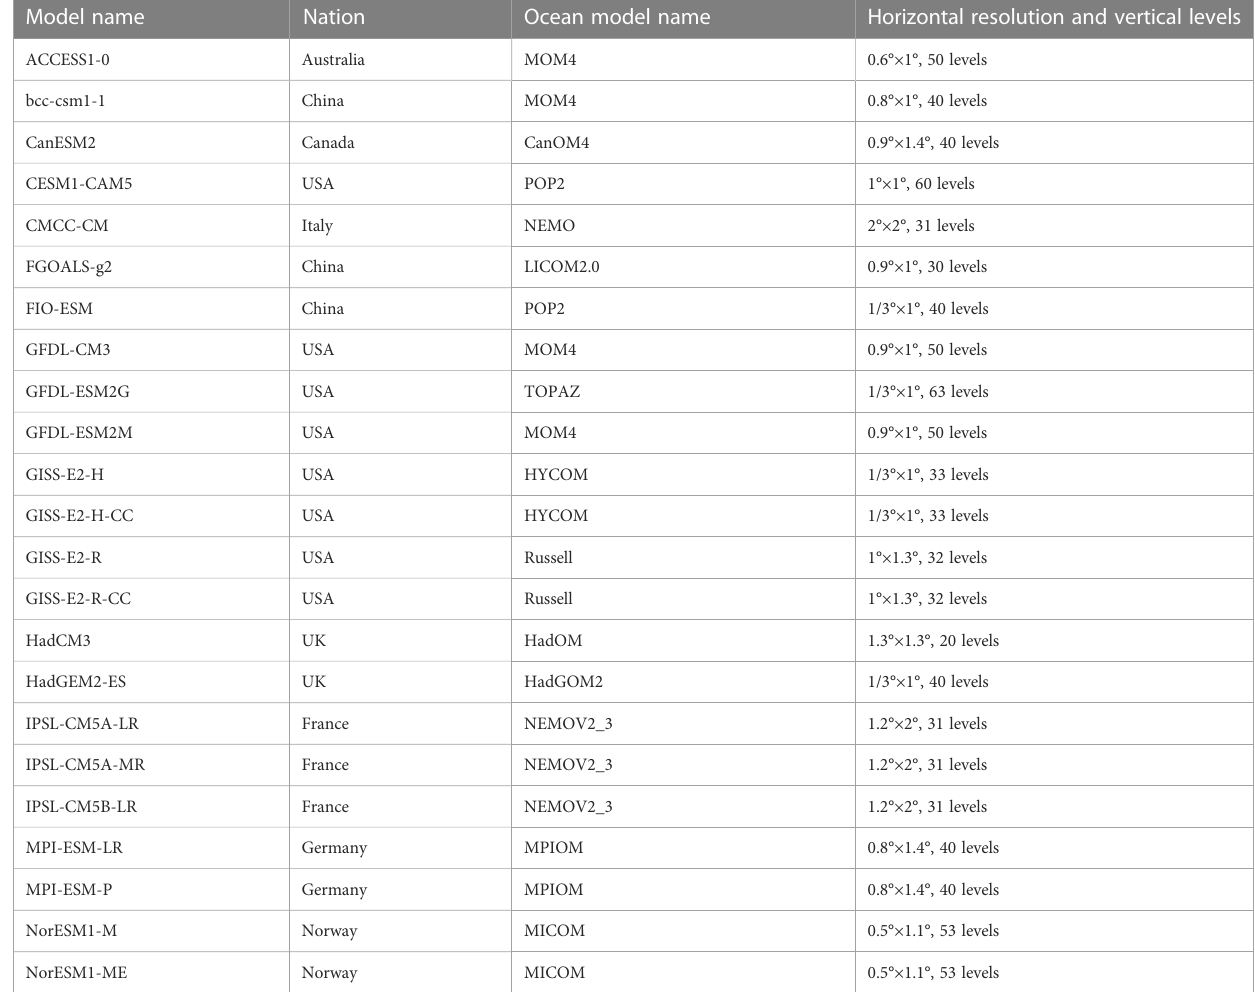
TABLE 1 Basic information of the 23 CMIP5 coupled models used in this